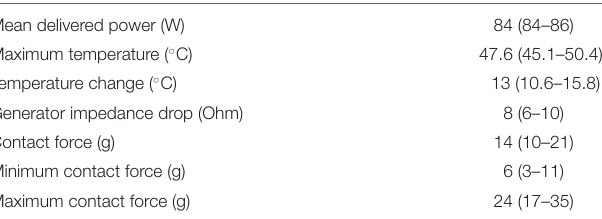
TABLE 2 | Baseline characteristics of vHPSD lesions, n = 6,551.